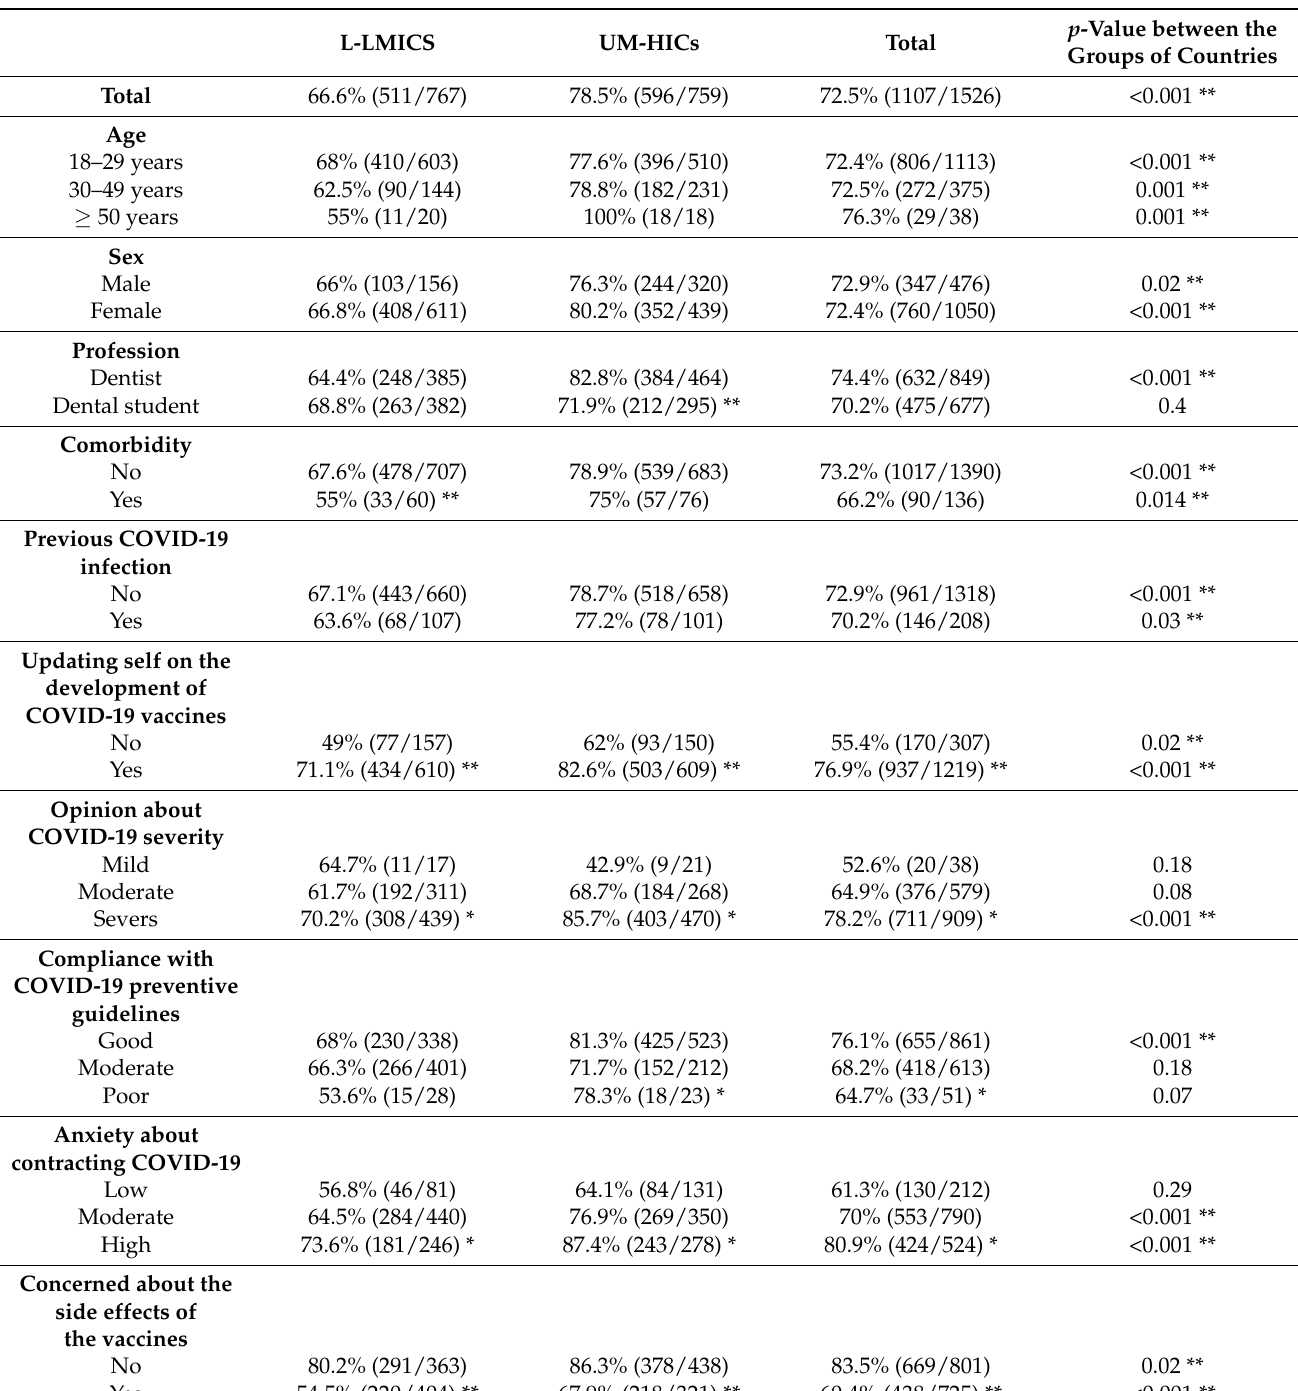
Table 4. Agreement among dentists/dental students in L-LMICs and UM-HICs to accept a COVID-19 vaccine. Data are presented as % ( n